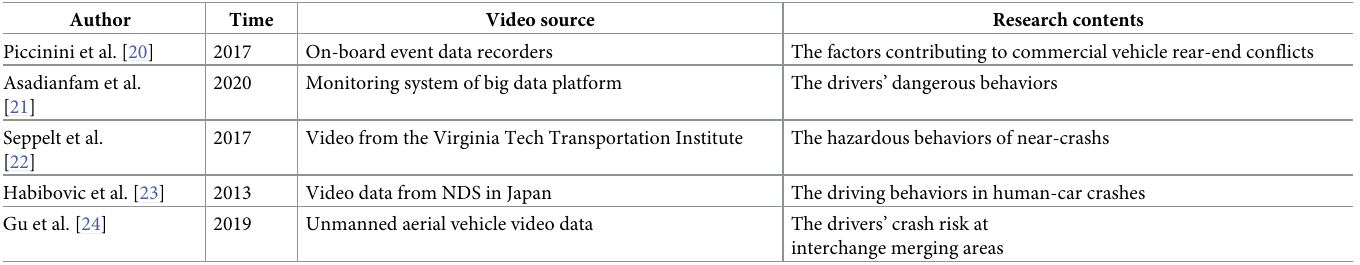
Table 1. Research in studying driver’s unsafe behaviors by